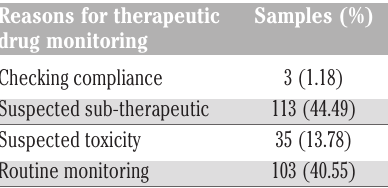
Table 3. Reasons for therapeutic drug monitoring (n=254).